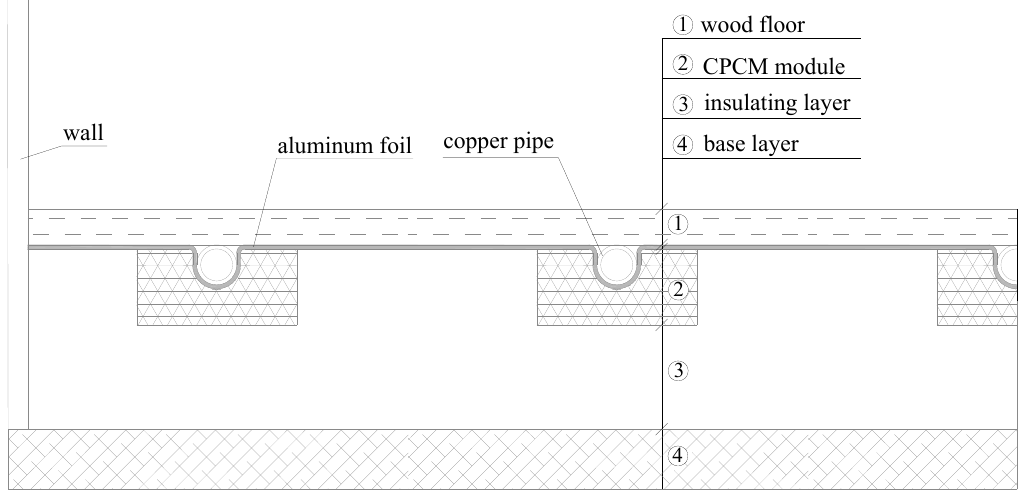
Figure 2. Structure of the radiant floor heating terminal with composite phase change material (CPCM) modules.